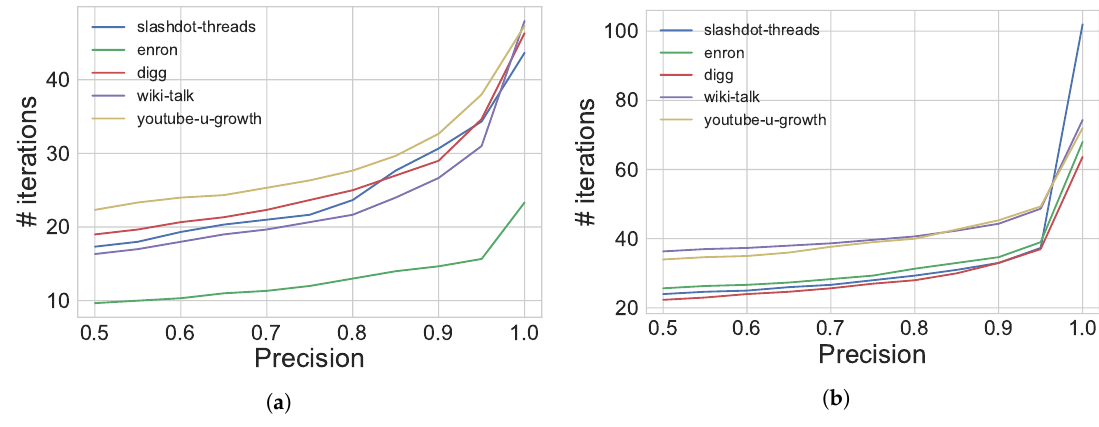
Figure 4. Katz precision vs. iteration count. ( a ) R = 100, ( b ) R =